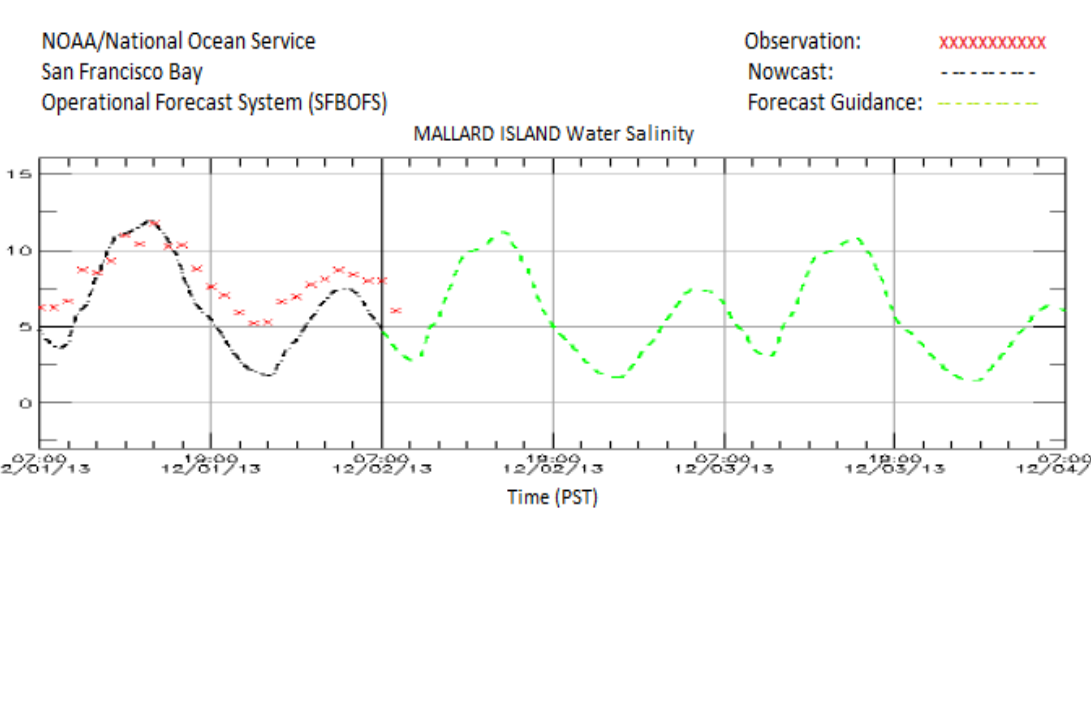
Figure 11. The nowcast/forecast water surface salinity versus measurement at stations where the Sacramento and San Joaquin Rivers have noticeable effects on salinity